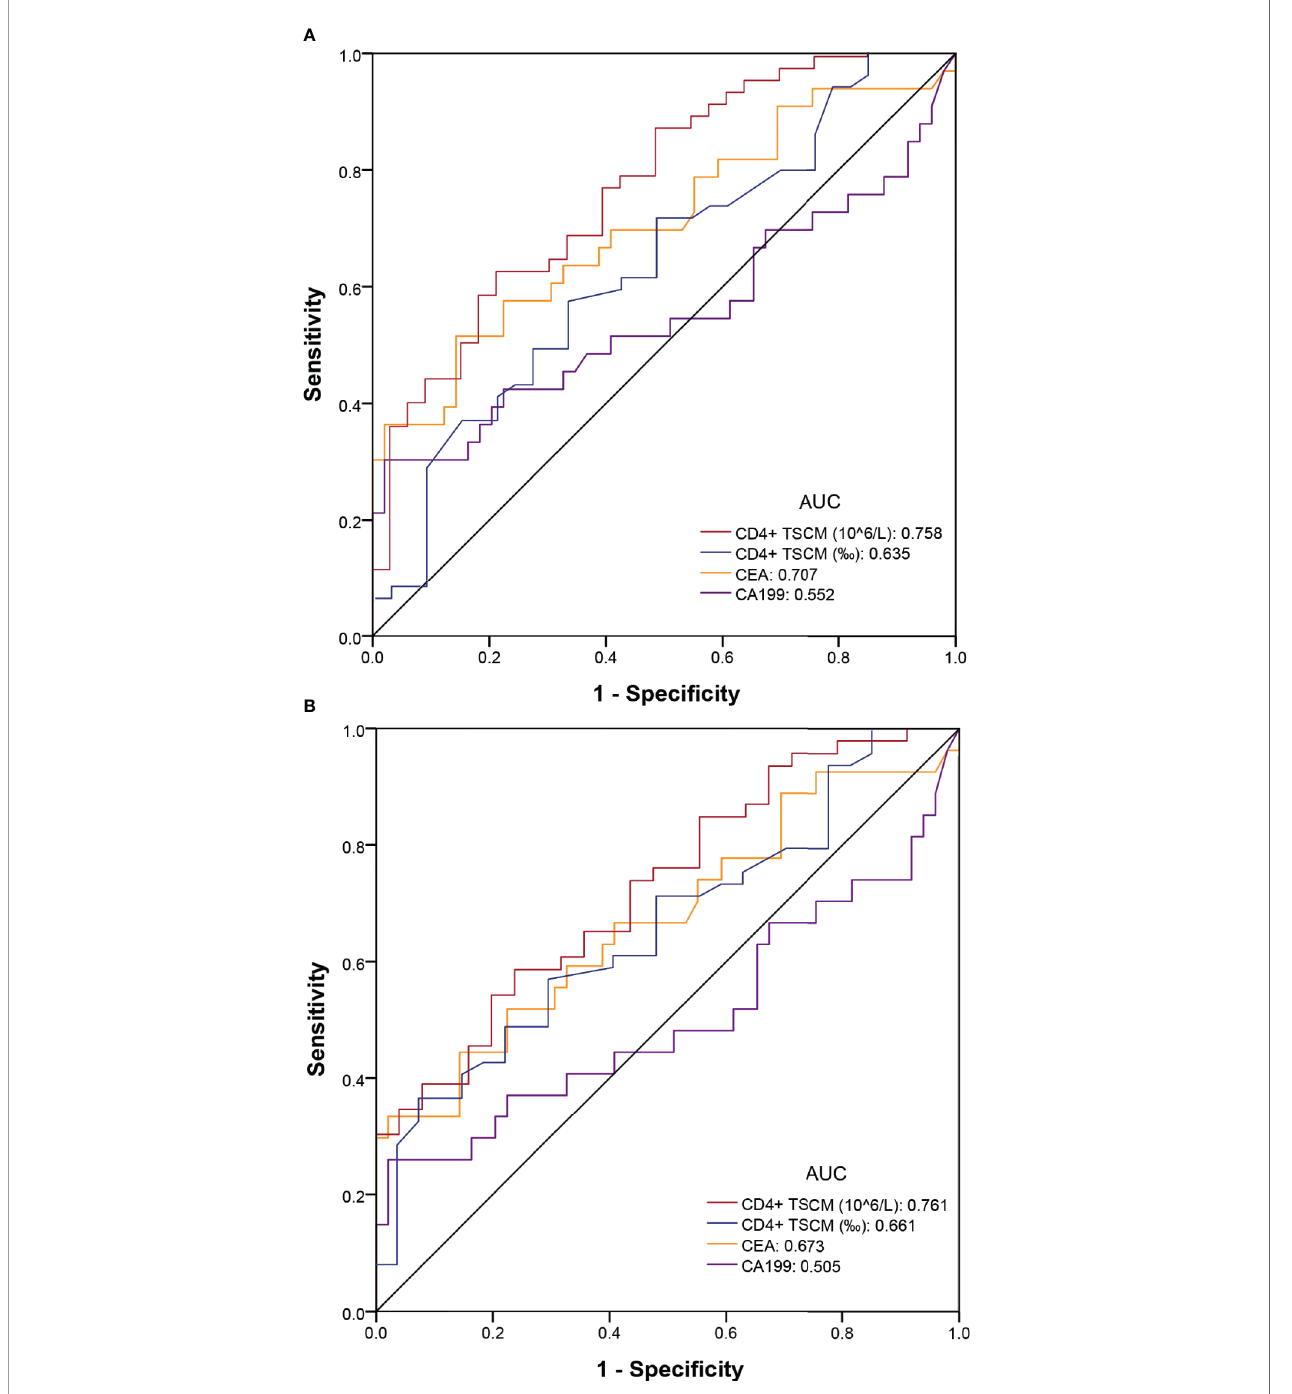
FIGURE 4 | Receiver operating characteristic (ROC) curve of colorectal cancer for early screening and auxiliary diagnosis. (A) Colorectal cancer (pTNM stage I – IV) and healthy control groups; (B) Colorectal cancer (pTNM stage I – III) and healthy control